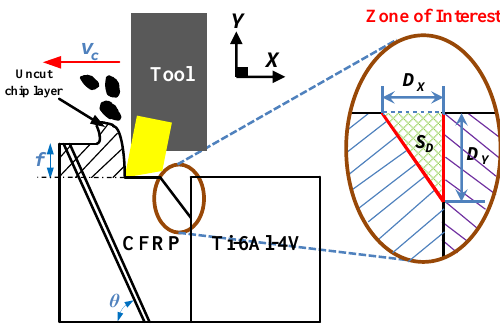
Figure 12. Scheme of delamination damage evaluation in CFRP/Ti cutting.